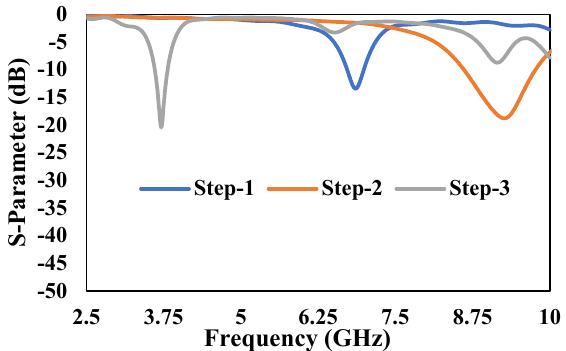
Figure 1. Step -by-Step design of proposed antenna ( a ) Triangular Patch ( b ) Square Patch ( c ) Com- bined Triangular and Square patch.